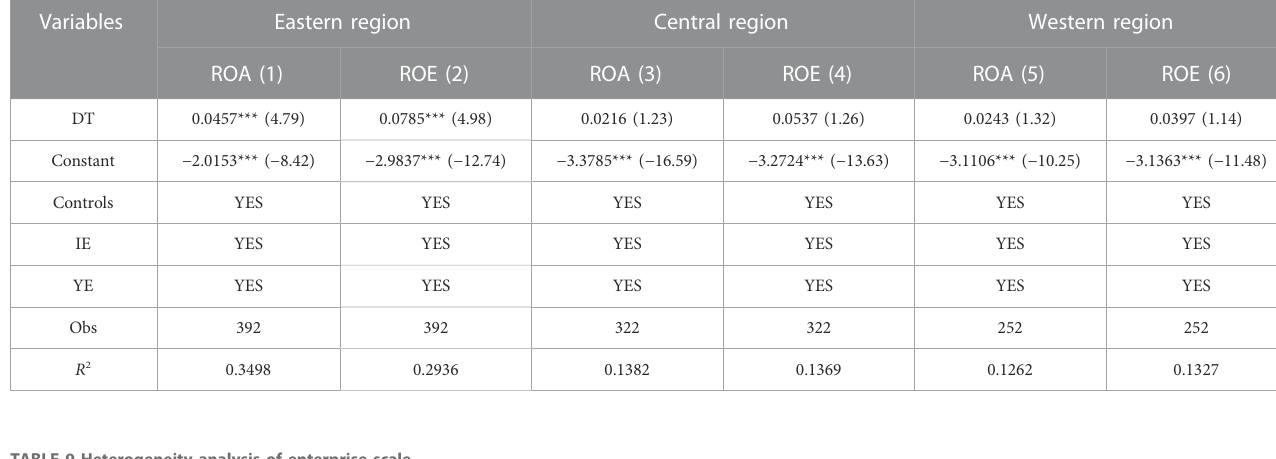
TABLE 9 Heterogeneity analysis of enterprise scale.